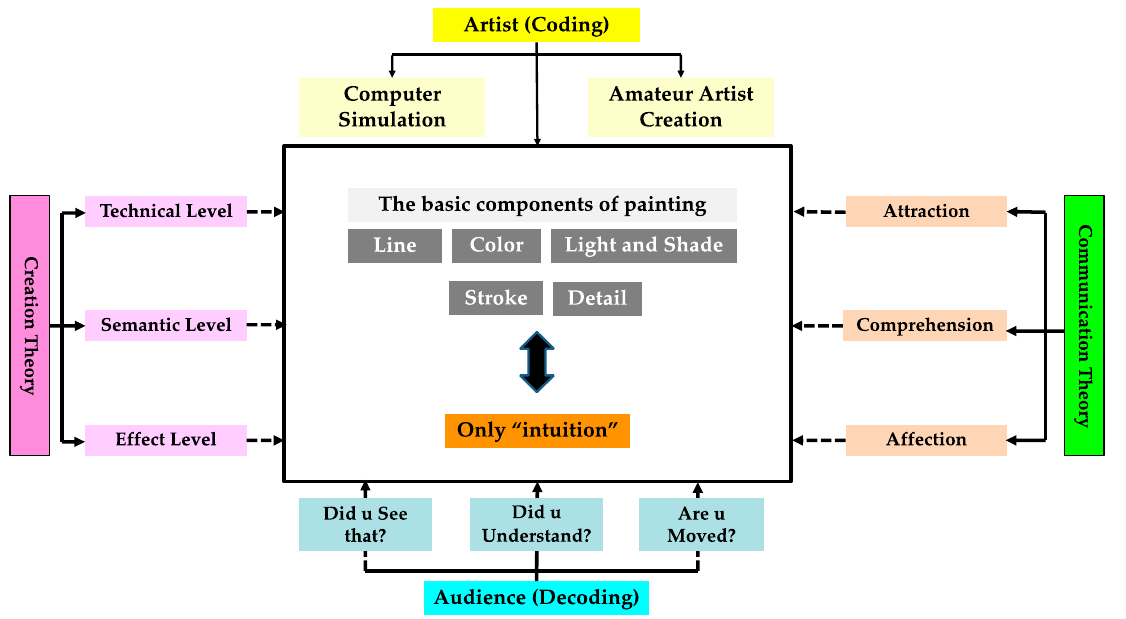
Figure 2. A communication matrix for identifying the paintings created by humans or computer artists. (Source: this study).